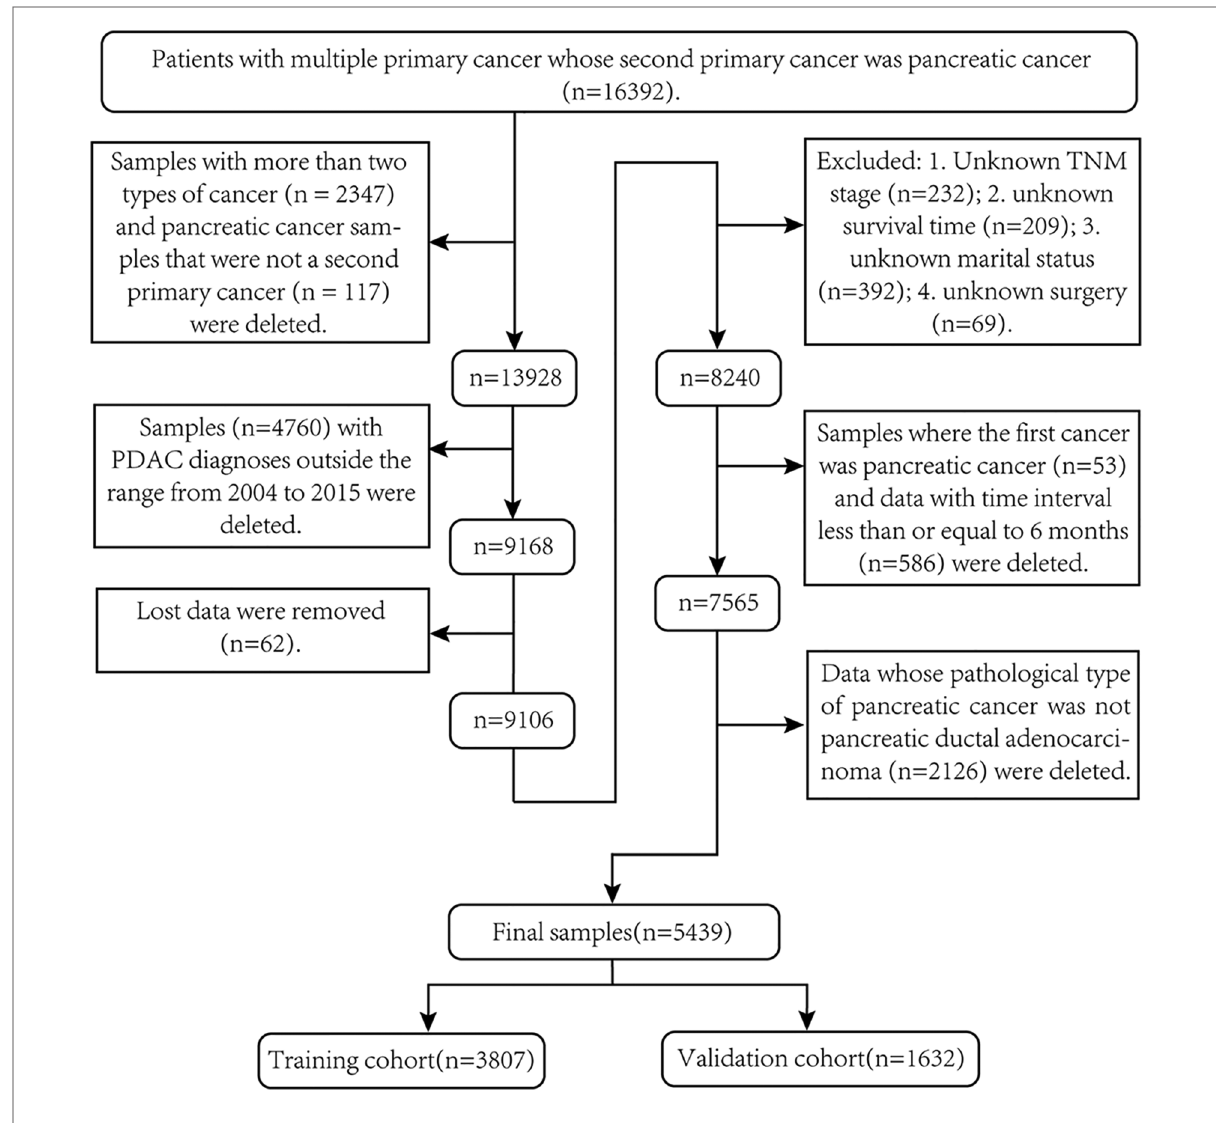
FIGURE 1 Screening process for second primary pancreatic ductal adenocarcinoma samples required for this